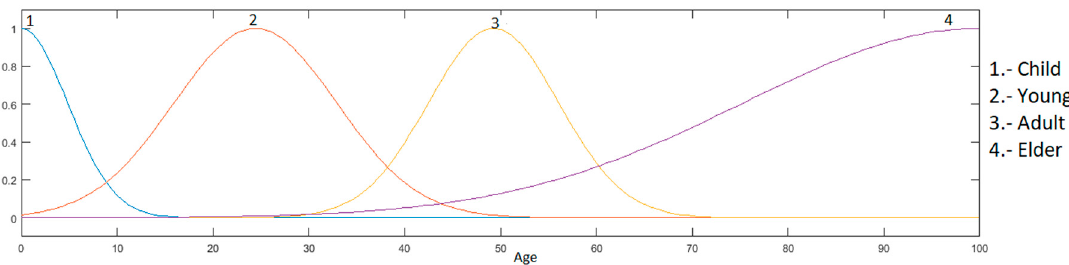
Figure 20. Optimized input heart rate. Figure 21. Optimized output heart rate level. In Figure 19 and Figure 20, the inputs of the fuzzy system with optimized trapezoidal membership functions are illustrated. Likewise, in Figure 21 the output with optimized trapezoidal membership functions is presented. In the same way, in Figure 22 and Figure 23 the inputs of the optimized fuzzy system with